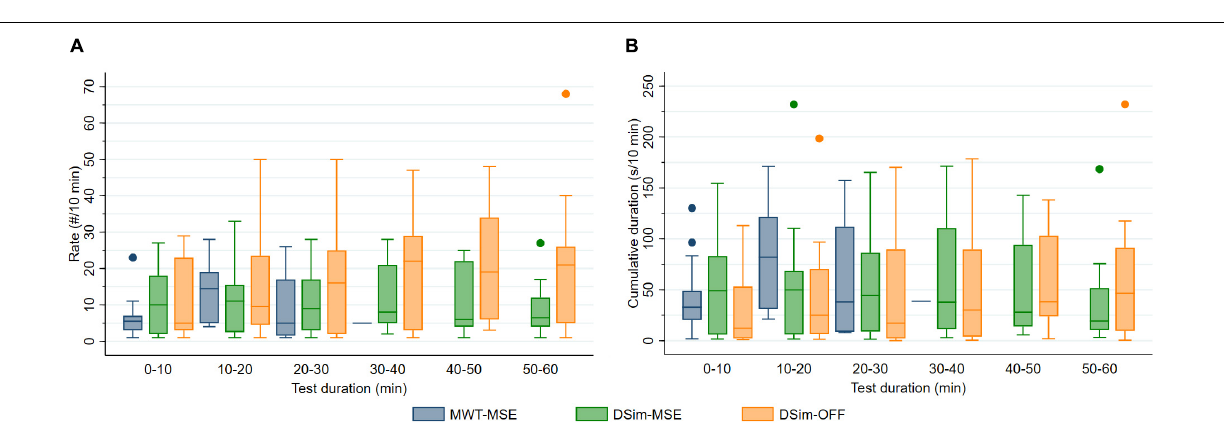
FIGURE 4 | (A) Rate (#/10 min) and (B) cumulative duration (s/10 min) of microsleep episodes (MSEs) and off-road events (OFF) during the maintenance of wakefulness test (MWT) and driving simulator (DSim) after sleep deprivation. Data were analysed until sleep onset and displayed in 10-min bins (4 boxplots for the MWT and 6 for the